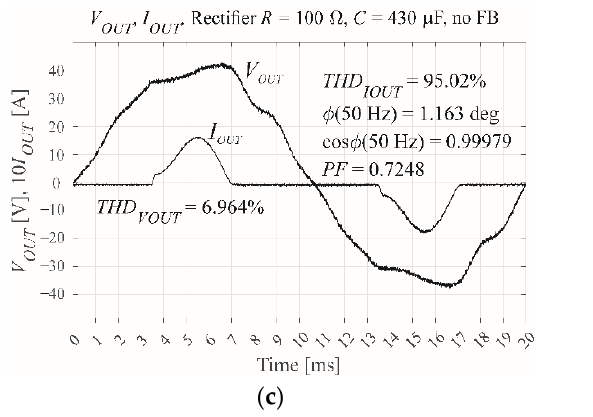
Figure 7. The measured output voltage and current of the experimental VSI using MicroLabBox real time interface when subject to a nonlinear rectifier RC load, showing ( a ) open loop with R = 100 Ω, C = 100 μF, and PF = 0.7, ( b ) CDM control with R = 100 Ω, C = 100 μF, and M = 0.6, ( c ) open loop with R = 100 Ω, C = 430 μF, and PF = 0.7, and ( d ) CDM control with R = 100 Ω, C = 430 μF, and M = 0.6.